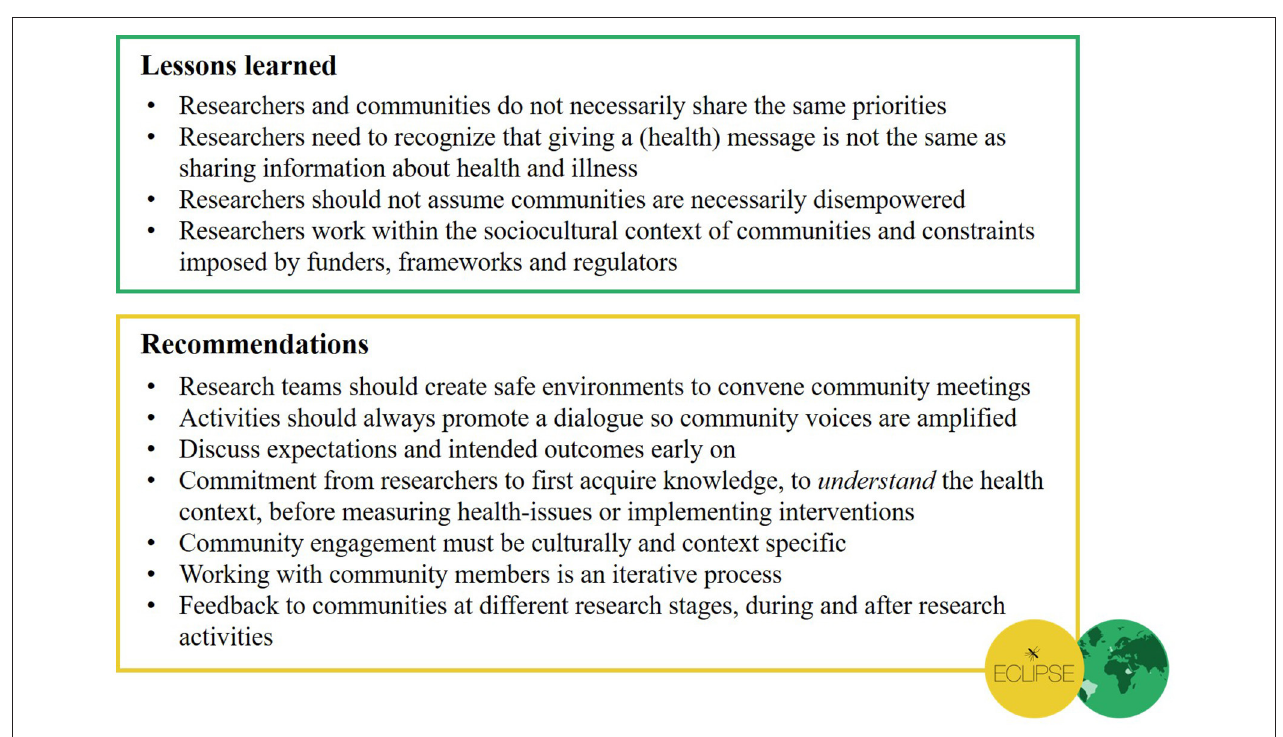
FIGURE 10 | Summary of our lessons learned and recommendations for conducting community engagement in global health